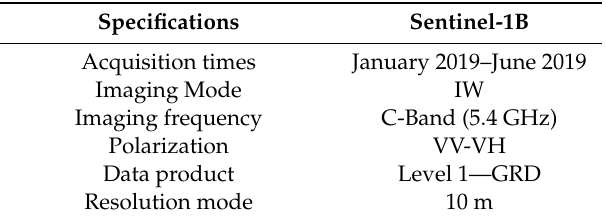
Table 1. Specifications of the Sentinel-1B data used in the